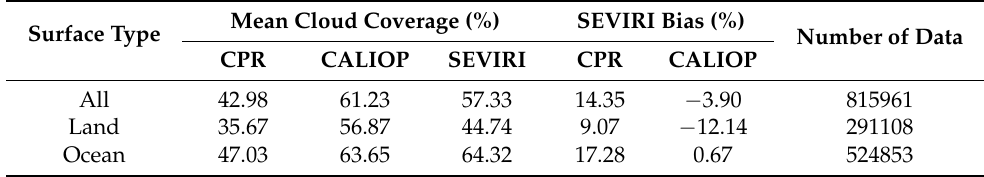
Table 3. Mean cloud occurrence frequencies and the biases of Spinning Enhanced Visible and Infrared Imager (SEVIRI) cloud products with regard to the surface type (land/ocean) for a one-year validation period.